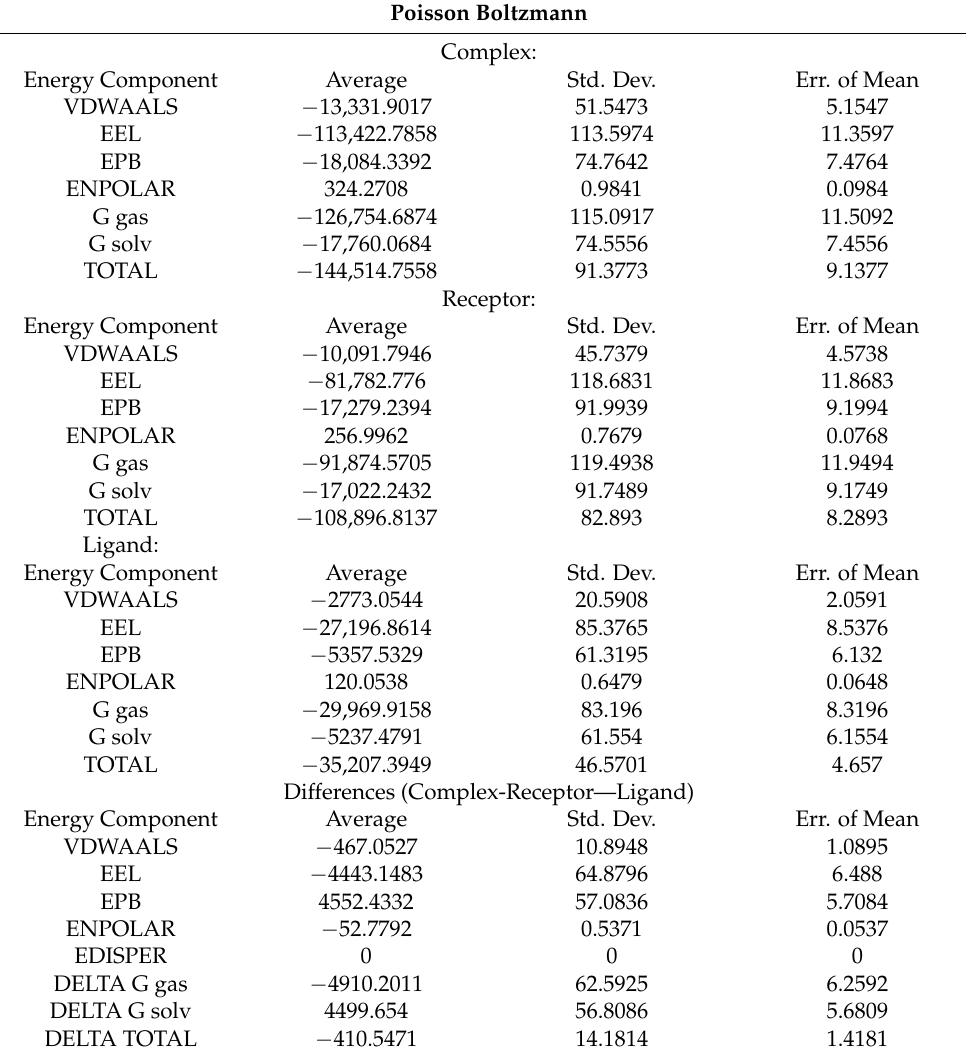
Table 6. Calculations of the Poisson Boltzmann equations are carried out utilizing sander’s internal PBSA solver. Each value is given in